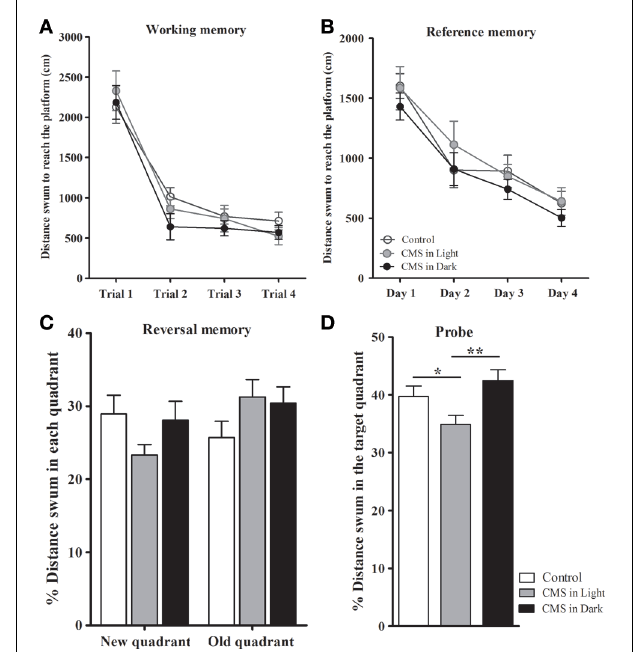
FIGURE 4 | Impact of CMS during different phases of the day light-dark cycle on spatial working, reference and reversal memory. (A) Average distance swum during the spatial working memory task. (B) Average distance swum during the reference memory task. (C) Percentage of distance swum in the new/old quadrant during the reversal memory task. (D) Percentage of distance swum in the target quadrant during the probe test. Controls, n = 20, each CMS group, n = 14; ∗ P < 0 . 05. ∗∗ P < 0 . 01. Data presented as mean ±